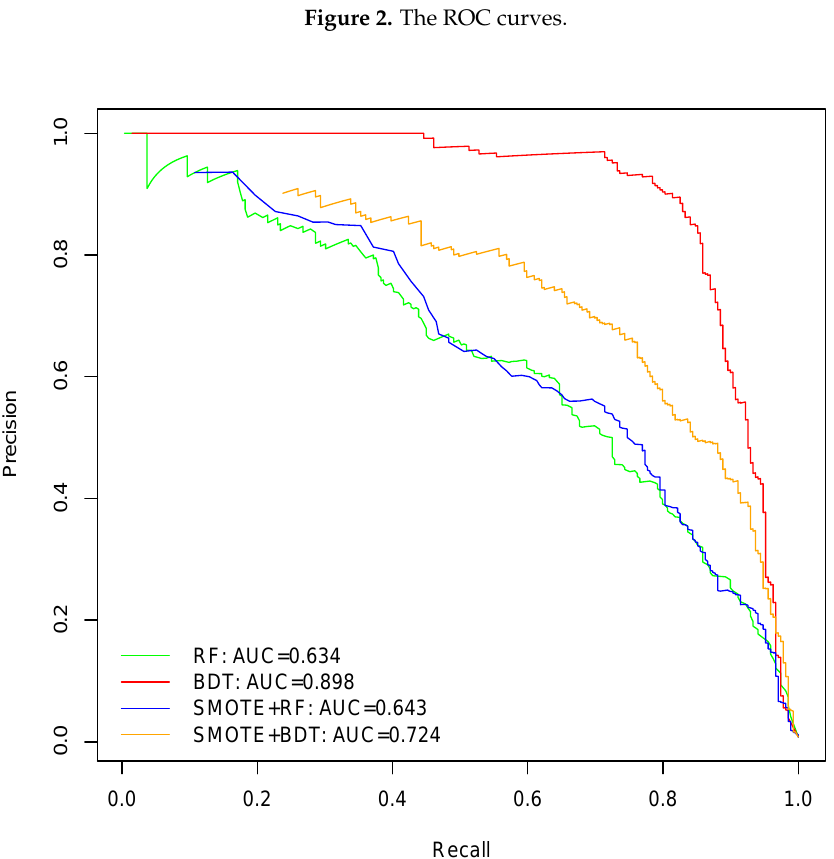
Figure 3. The PR